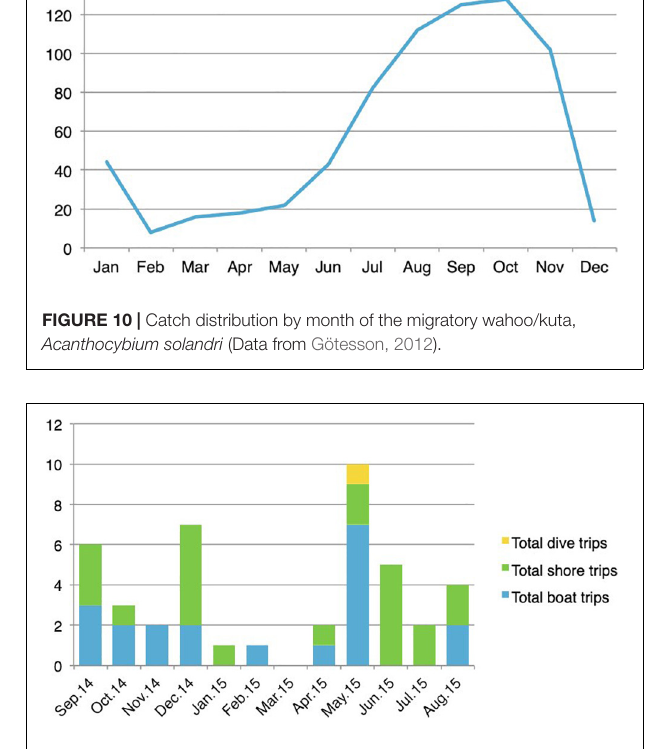
FIGURE 11 | Distribution of fishing practices during the year (September 2014–August 2015) (after Dawson and Irving,